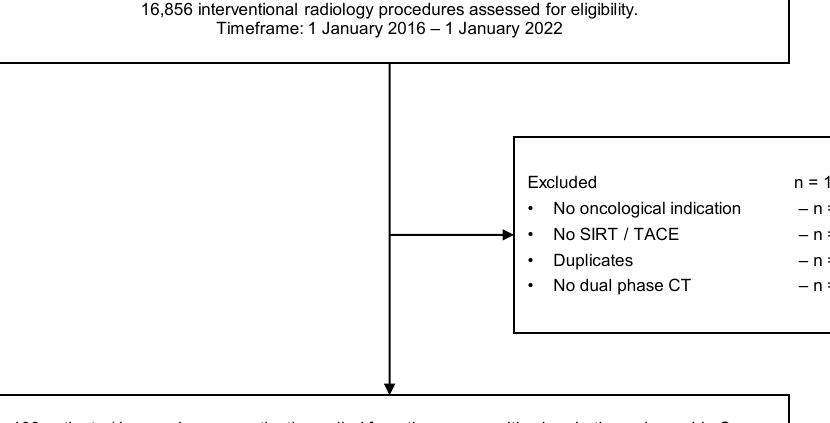
100 patients (1 procedure per patient) enrolled from the same multi-axis robotic angiographic C-arm System (Artis Zeego Q, Siemens Healthineers, Forchheim, Germany)